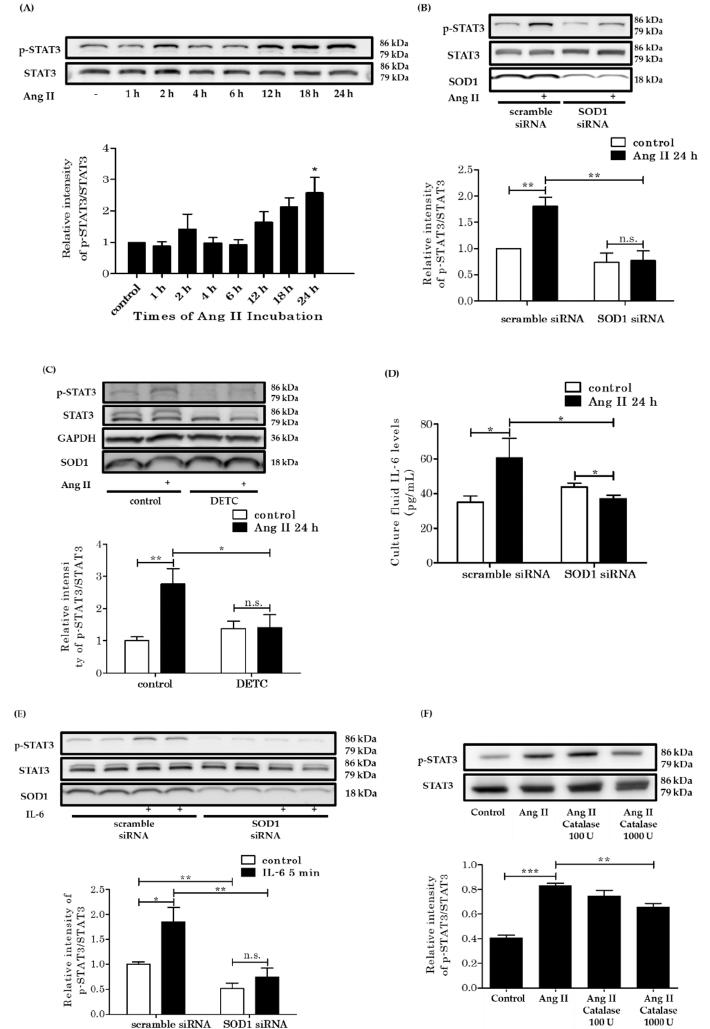
Figure 6. Rat vascular smooth muscle cells (VSMCs) incubated with AngII. ( A ) Time course of STAT3 phosphorylation of VSMCs due to AngII. VSMCs were stimulated with 100 nM AngII for the indicated times. The top panels are representative immunoblots for Ang II-induced phosphorylation of STAT3. The bottom panels represent averaged data quantified by densitometry of immunoblots, expressed as fold increases in phosphorylation, in which the phosphorylation for the con- trol was defined as 1.0 ( n = 4 per group. * p < 0.05) ( B ) The expression of phosphorylated STAT3 of VSMCs induced with AngII. The expression of SOD1 was downregulated with SOD1 siRNA (6 nM). The bottom panels represent quantification of densitometry, expressed as fold increases in phosphorylation, in which the phosphorylation for “scramble siRNA con- trol’’ was defined as 1.0 ( n = 7 per group. * p < 0.05 ** p < 0.01 n.s.: not significant). ( C ) The SOD1 activity was pharmacolog- ically inhibited by 0.1 mM DETC (copper-chelating compound). DETC was added to VSMC culture fluid 4 h before AngII.